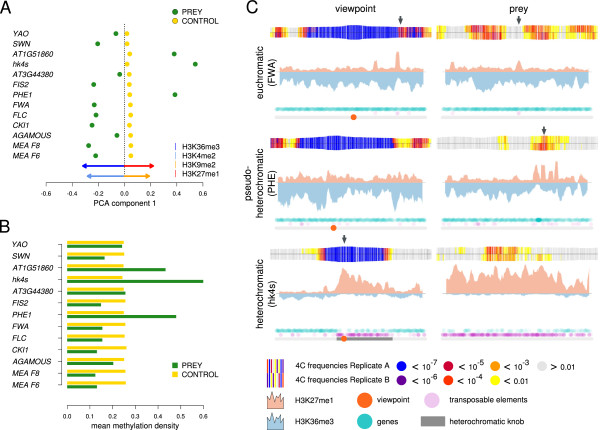
Crosstalk of epigenome and interactome. (A) Principal component analysis (PCA) using mean epigenetic modification densities (EMDs) of control and prey regions for each viewpoint. EMDs included in the PCA were: H3K4me2, H3K4me3, H3K9me2, H3K27me1, H3K27me3, H3K36me2, H3K36me3, H3K9ac, and H3K18ac. Colored arrows represent the two highest contributing EMDs to the variance of the first component in positive and negative direction, respectively. Note that the first principal component explains almost all the variance (97%), and therefore, this was the only component plotted. Prey regions are represented by green dots, control regions by yellow dots. (B) Mean CG methylation densities of prey and control regions for individual viewpoints. The mean was calculated across 1000 times randomly sampled 50 prey and 50 control regions, respectively. Green bars represent preys and yellow bars represent controls. (C) Examples of the interactome-epigenome interplay for three different viewpoints and one of their corresponding prey regions. Top track: log summed 4C reads per window (100 fragments, starting every fragment). 4C reads of replicate A are plotted in the positive intercept, and 4C reads of replicate B are plotted in the negative intercept. Middle Track: EMD of the highest contributing factors of the PCA in positive and negative direction, respectively. In order to achieve comparable representation of H3K36me3 and H3K27me1 densities, the density of every window (25 fragments, starting every 5 fragments) was divided by the mean density of each histone modification. Arrowheads point at regions where the 4C interactome and local EMD peaks appeared to correlate. FWA: viewpoint on chromosome 4, 12 to 14 Mb; prey on chromosome 5, 23 to 25 Mb. PHE: viewpoint on chromosome 1, 23.5 to 25.5 Mb; prey on chromosome 1, 20 to 22 Mb. hk4s: viewpoint on chromosome 4, 0.8 to 2.8 Mb; prey on chromosome 2, 4 to 6 Mb.